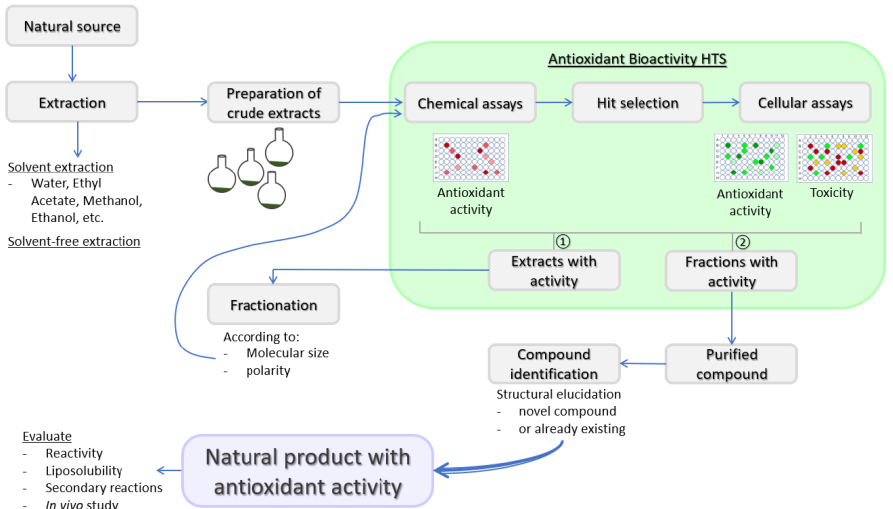
Figure 1. Workflow for the natural products discovery. Extracts from a natural source, such as a